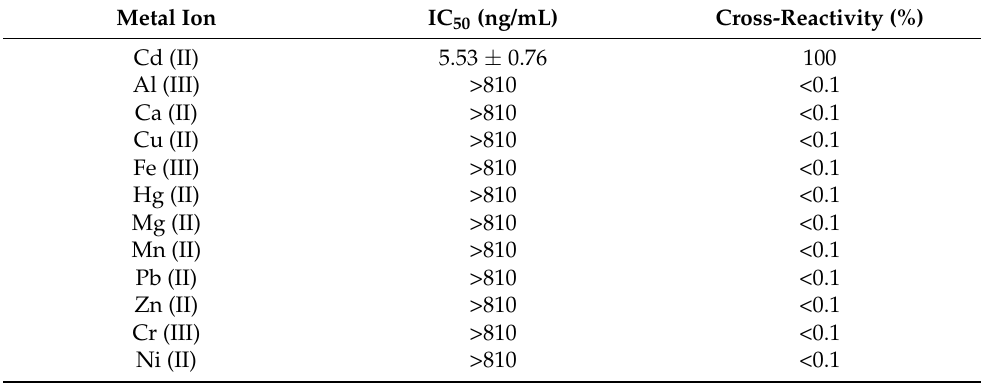
Table 2. Cross-reactivity of anti-cadmium monoclonal antibody with Cd (II) and other metal ions.